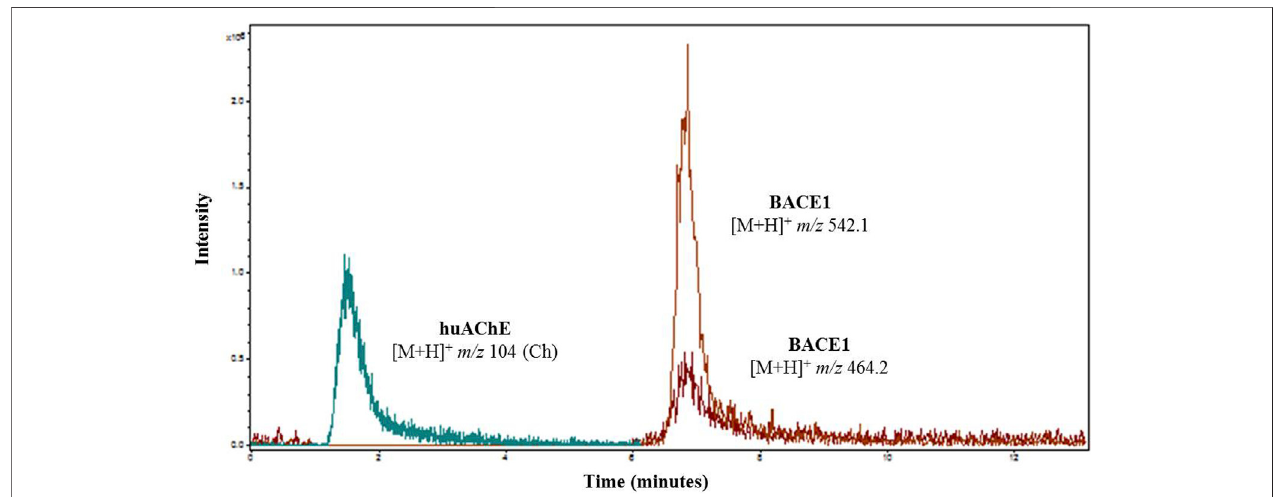
FIGURE 2 | Overlap of extracted ion chromatogram obtained after injection of 50 µM ACh into the huAChE-ICER-LC-MS system and 50 µM JMV2236 into the BACE1-ICER-LC-MS system. The products of enzymatic hydrolysis were monitored at pH 4.5.